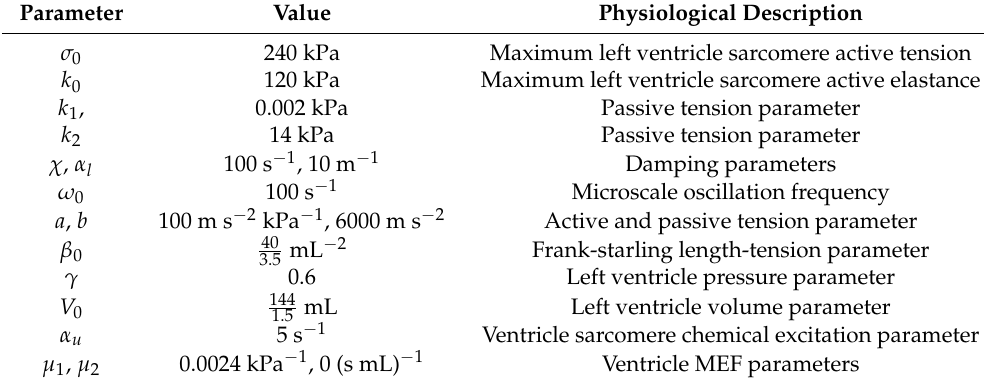
Table 2. Control parameters for ventricle micro-scale mechanical and electrical